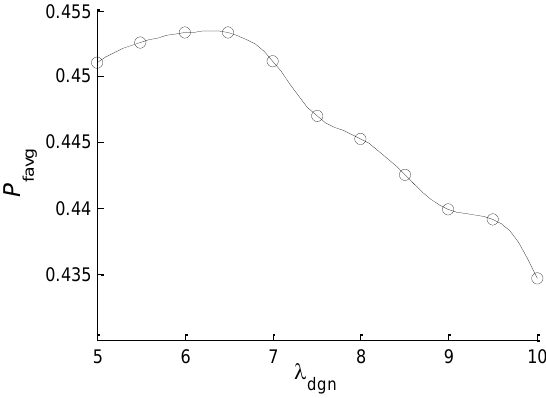
Figure 5. The relationship between P favg and λ dgn .